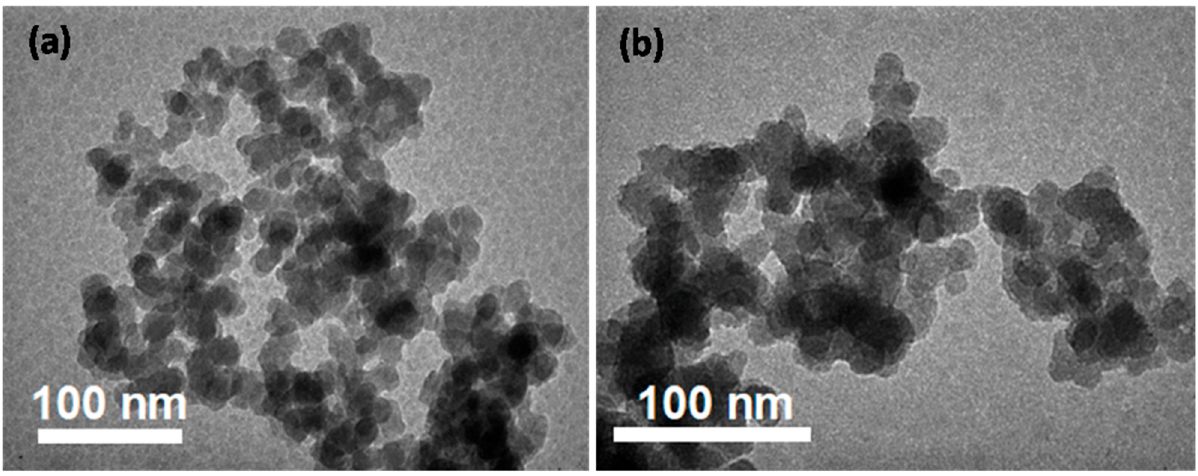
Figure 3. The TEM image of SiO 2 NPs ( a ) and the TEM image of SiO 2 @Cu@CMC NPs ( b ).